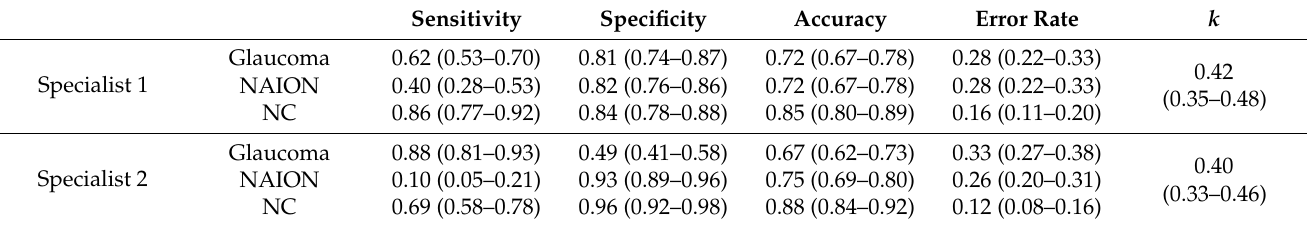
Table 3. Performance of specialists for glaucoma, non-arteritic anterior ischemic optic neuropathy and normal control optical coherence tomography angiography (OCTA)